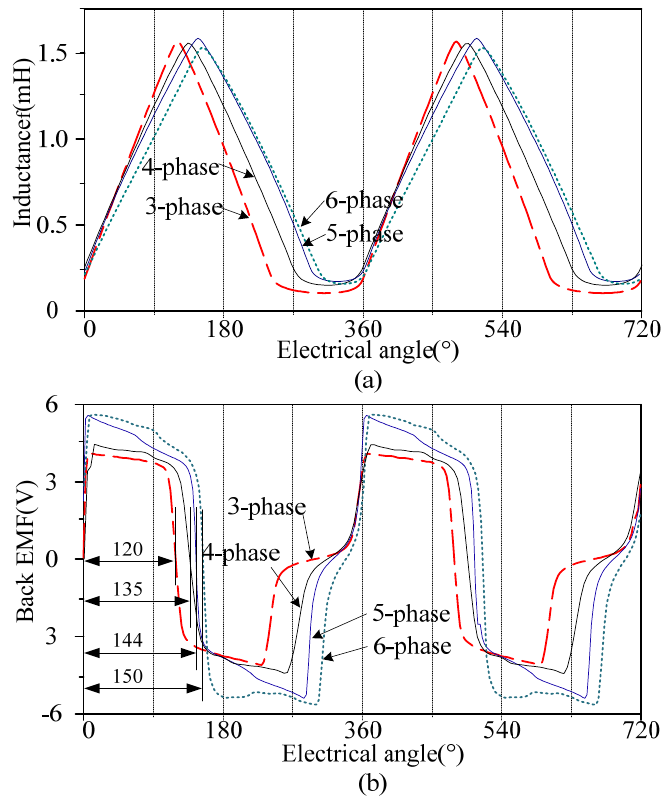
Figure 4. L pf and u p of multi-phase WFDSM. ( a ) L pf ; ( b ) The back EMF.